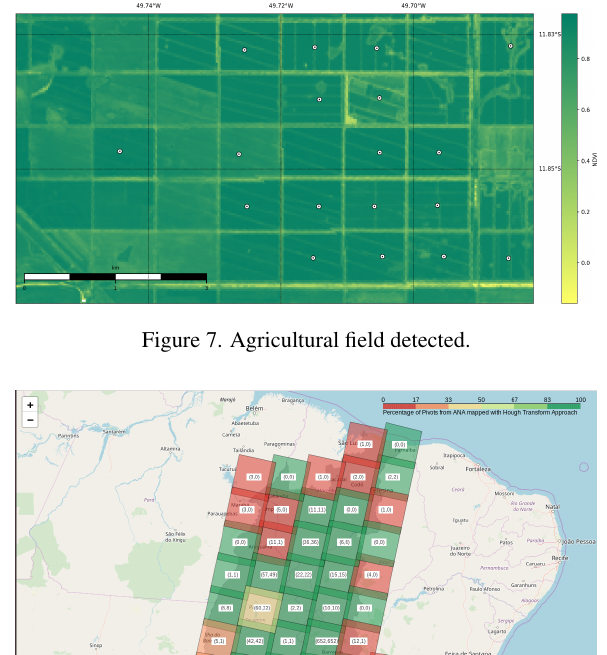
Figure 9. Center pivots mapped by ANA vs detected by our